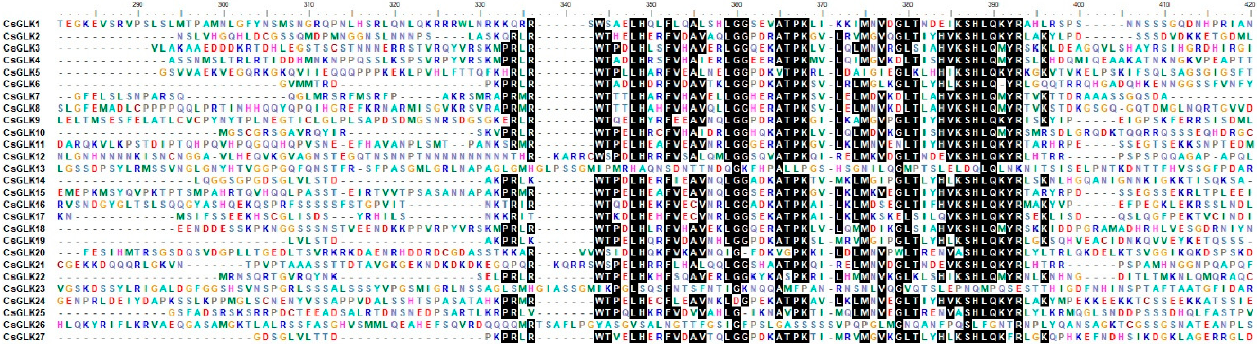
Figure 3. Multiple sequence alignment of the CsGLKs conserved domain. The same sequence was shown in black shadow.